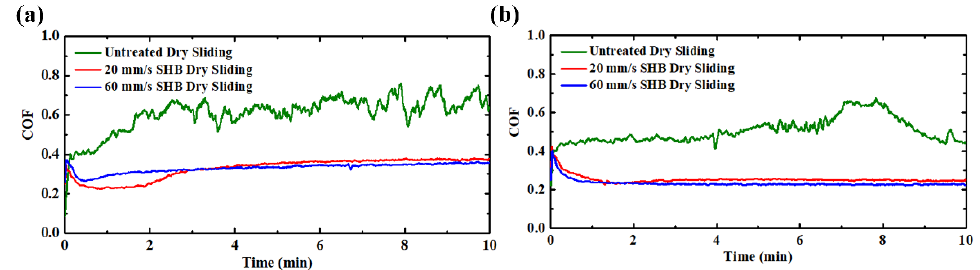
Figure 7. Variations of COF with respect to time for the untreated surface and the laser-heat-treated superhydrophobic (SHB) BMG surface under ( a ) dry sliding and ( b ) water lubrication conditions. Table 3. Average COF for different types of BMG surfaces under dry sliding and water lubrication